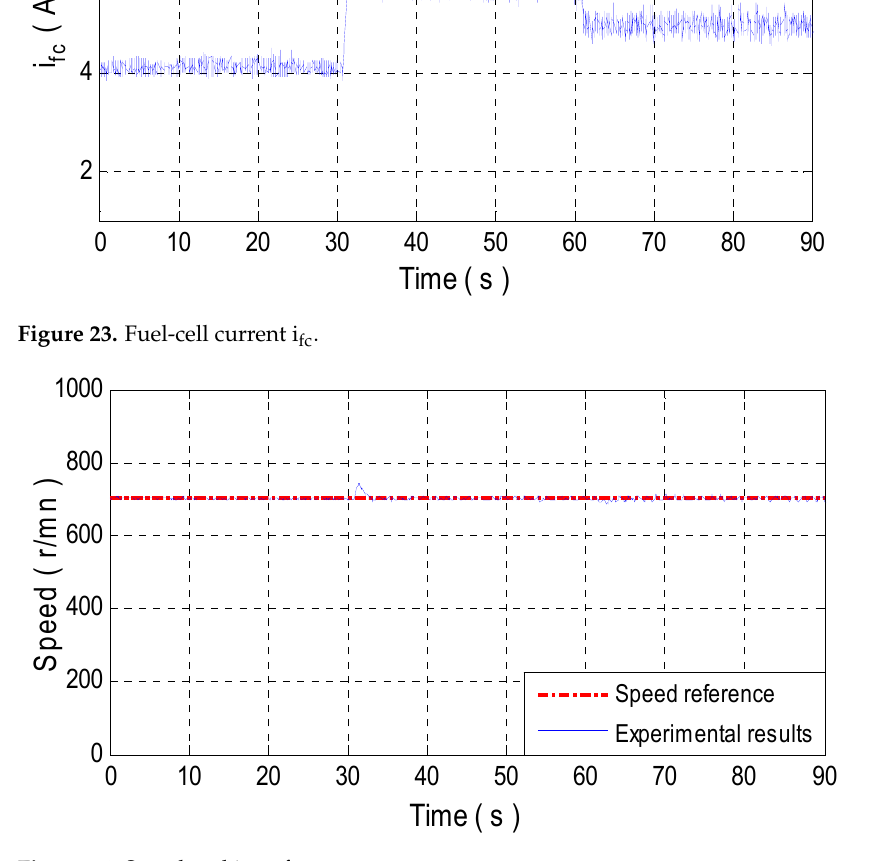
Figure 24. Speed and its reference.